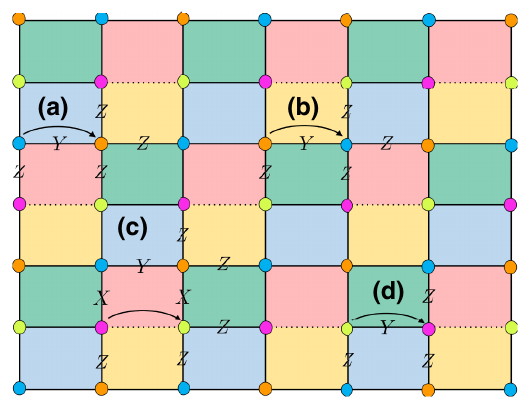
FIG. 20. Horizontal hoppings i γ L ( e ) γ R ( e ) after a finite-depth GLU transformation in Fig. 19. Labels (a) and (b) denote hop- pings between blue and orange dots; labels (c) and (d) denote hoppings between pink and yellow dots. Hoppings (a), (b), and (d) are exactly the horizontal hoppings in the exact bosoniza- tion, and hopping (c) is a product of the hopping operator and the stabilizer in the exact bosonization.